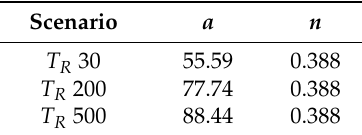
Table 1. IDF parameters for several return periods.